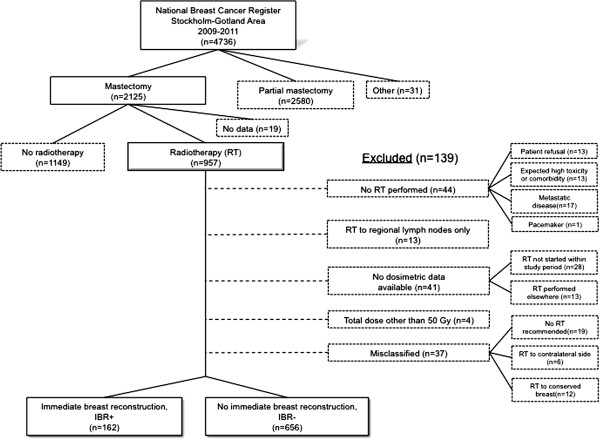
Study population, eligibility and inclusion/exclusion.